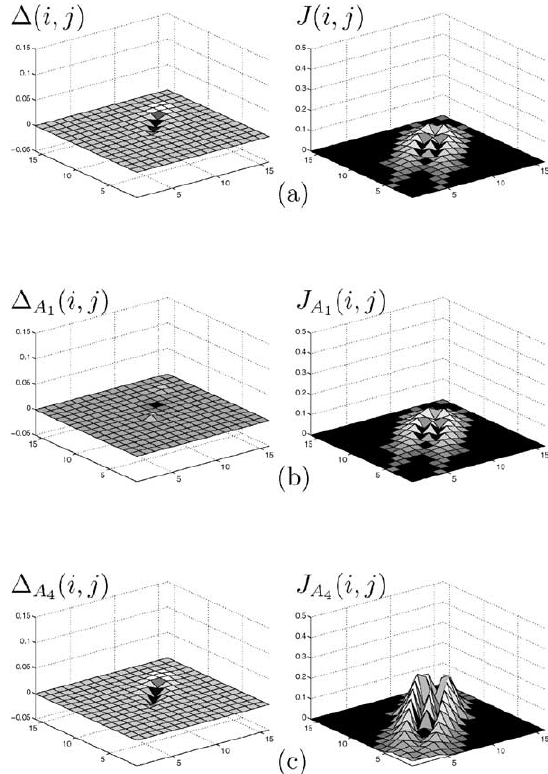
Fig. 7. Gray Level Cooccurrence Matrix (GLCM) Mahalanobis class distance matrices J ( i , j ) and GLCM class difference matrices ∆ ( i , j ) between the two prognostic classes of early ovarian cancer, com- puted from nuclear images with standardized first-order gray level statistics. The matrices were computed from (a) all 37,690 nuclei, (b) all nuclei within area interval A 1 (1000 (cid:1) nuclear area < 2000 pixels) and (c) all nuclei within area interval A 4 (4000 (cid:1) nuclear area < 5000 pixels). The positive (negative) values in the difference matrices correspond to GLCM matrix elements that are more (less) probable for the good prognosis class compared to the poor progno- sis class. The matrices were computed from the 70% central part of the